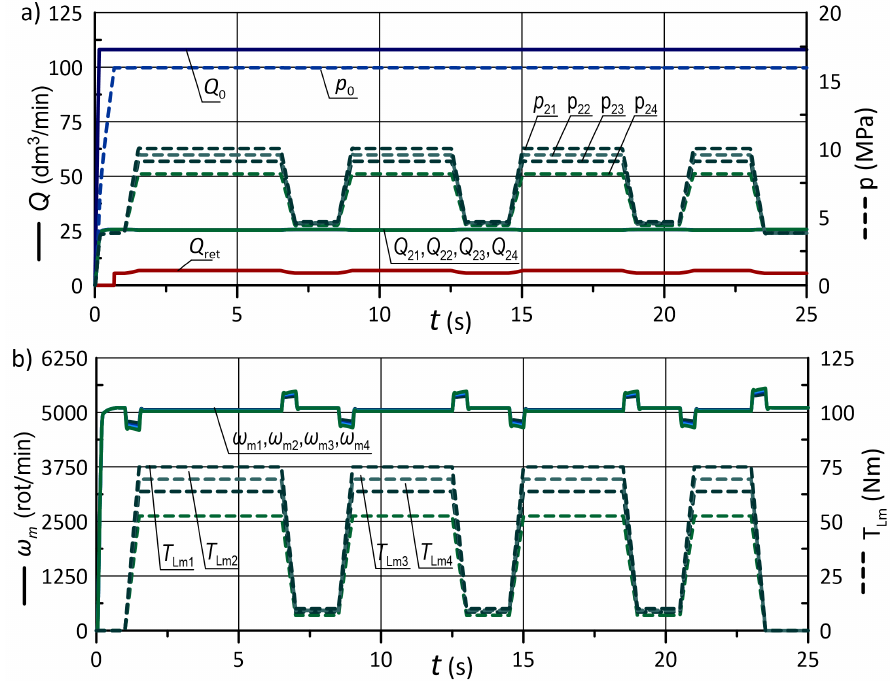
Figure 17. Operating cycle in a high load range, T Lm , max = 75 N m, with load variation of particular motors by 30%; ( a ) flow rates and pressures; ( b ) rotational speed of hydraulic motors and load